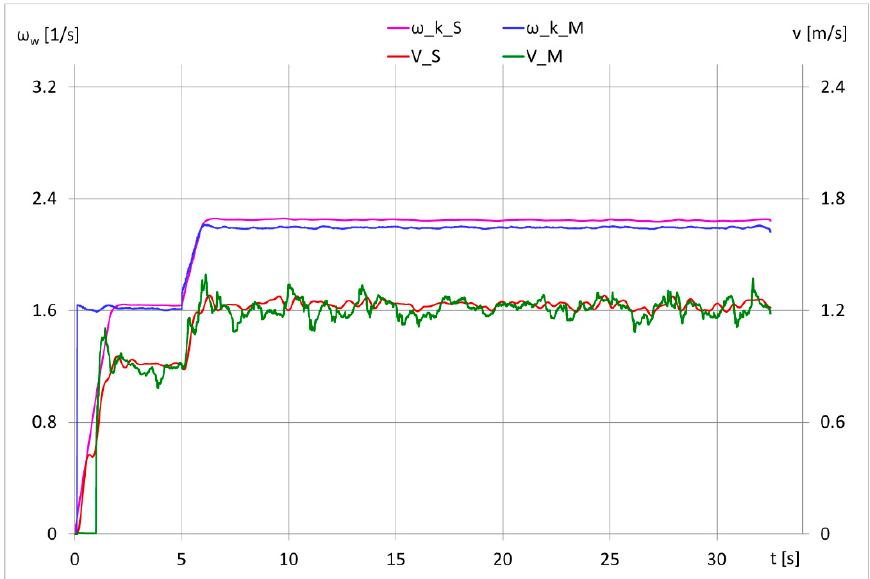
Figure 8. Changes in time of angular velocity of the drive wheel and tractor velocity, respectively; simulated ( ω _k_S, v_S ), and measured in field tests ( ω _k_M, v_M ), soil profile—silty loam, first gear.